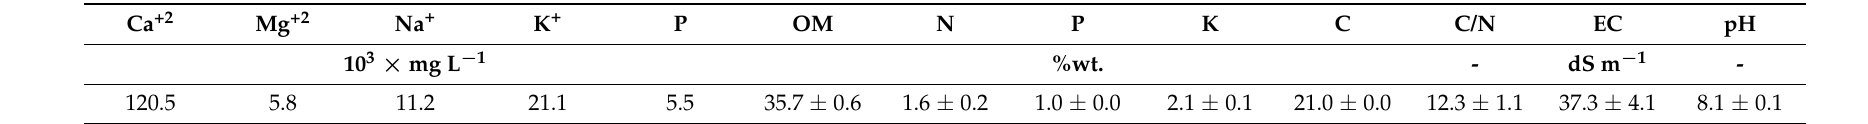
Table 3. Representative Yotvata composted biosolids composition (source: Dairy